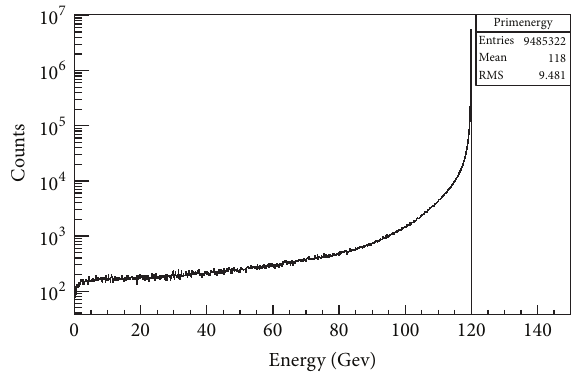
Figure 6: Spectrum of energy of 120 GeV primary beam after interaction with the detector materials before the ECAL1. The inefficiency in the beam with 𝐸 < 50 GeV is ∼ 0.7%.